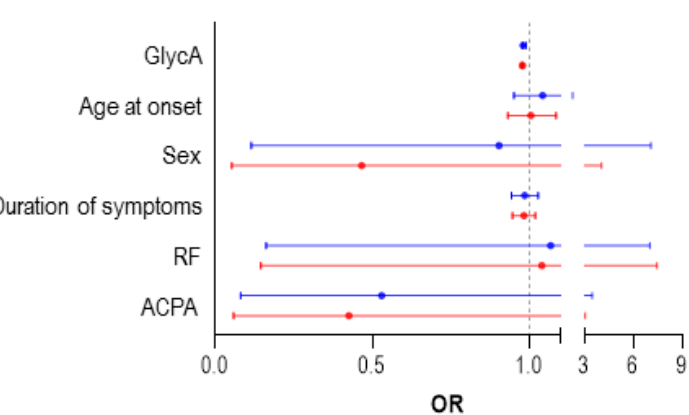
Figure 3. Predictors of Disease Activity Score 28-joints (DAS28) remission in treatment-naïve RA patients. Forest plot showing the odds ratio (OR) and 95% confidence interval (CI) of the different predictors of DAS28 remission achievement at 6 (red) and 12 (blue) months in fully adjusted, multivariate regression models (Table 3). ACPA, Anti-citrullinated protein antibodies; RF, rheumatoid factor.